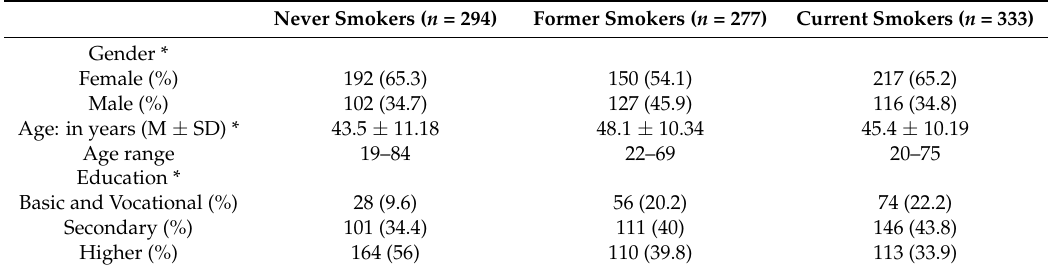
Table 1. Demographic characteristics of 904 participants examined in the study according to smoking